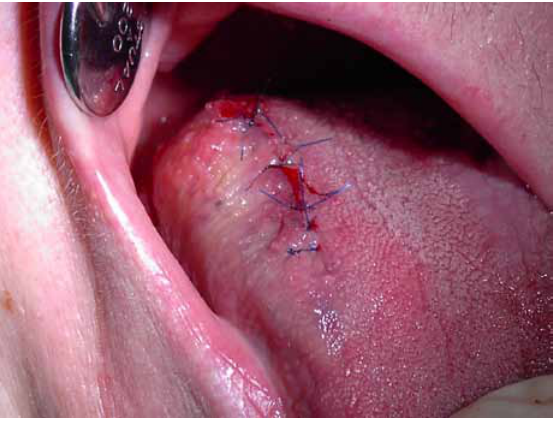
Figure 3. Wound after excision of the tumour.